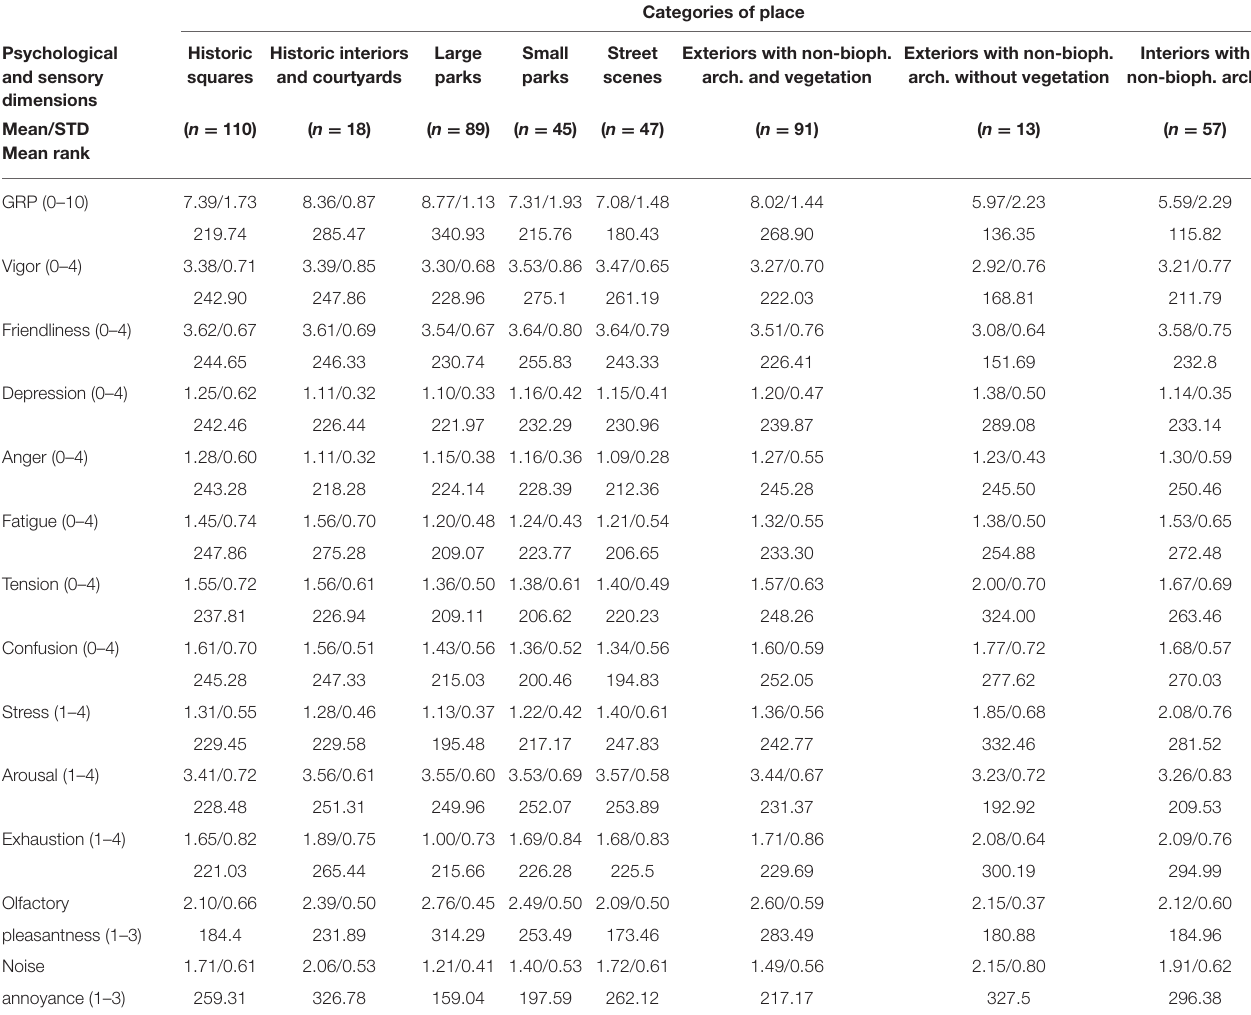
Categories of place